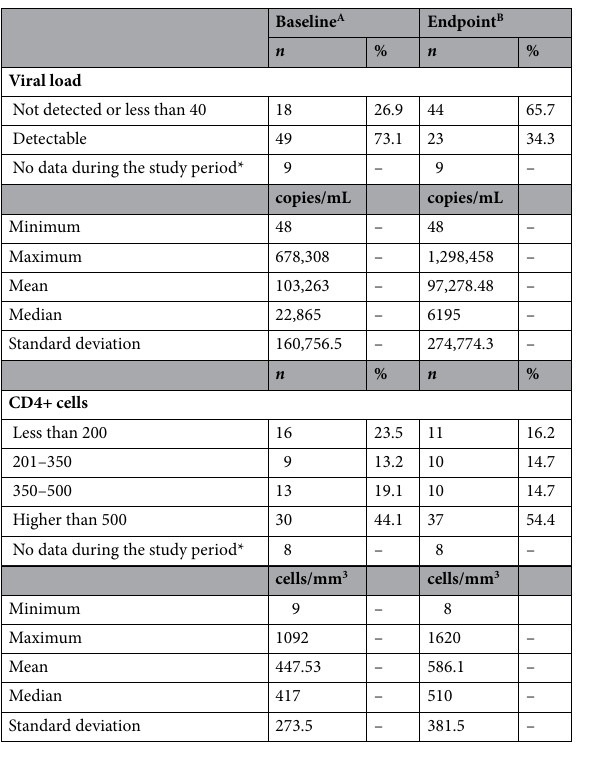
Table 3. Frequencies and descriptive measures of HIV viral load and CD4+ cells according to initial and final study periods ( n = 76). Data source: Laboratory Test Control System of the National Network for CD4+ Lymphocyte Count and HIV Viral Load (SISCEL). *Not included in descriptive analysis. A Refers to the closest measure of 2014. B Refers to the closest measure of